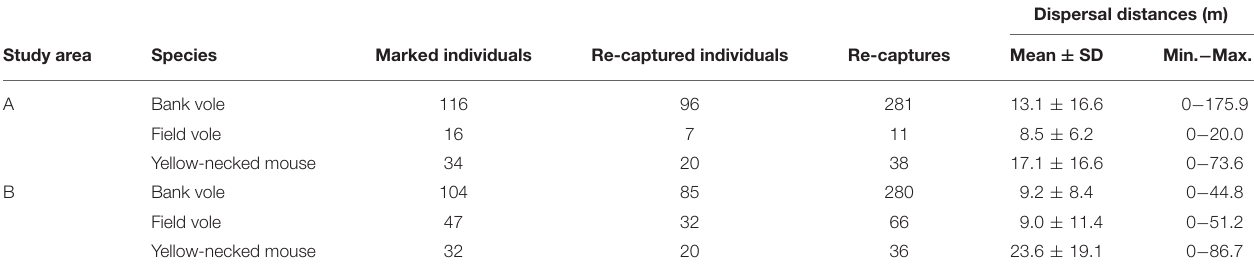
TABLE 3 | Summary of dispersal distances of marked mice and voles over 8 weeks during autumn 2012.